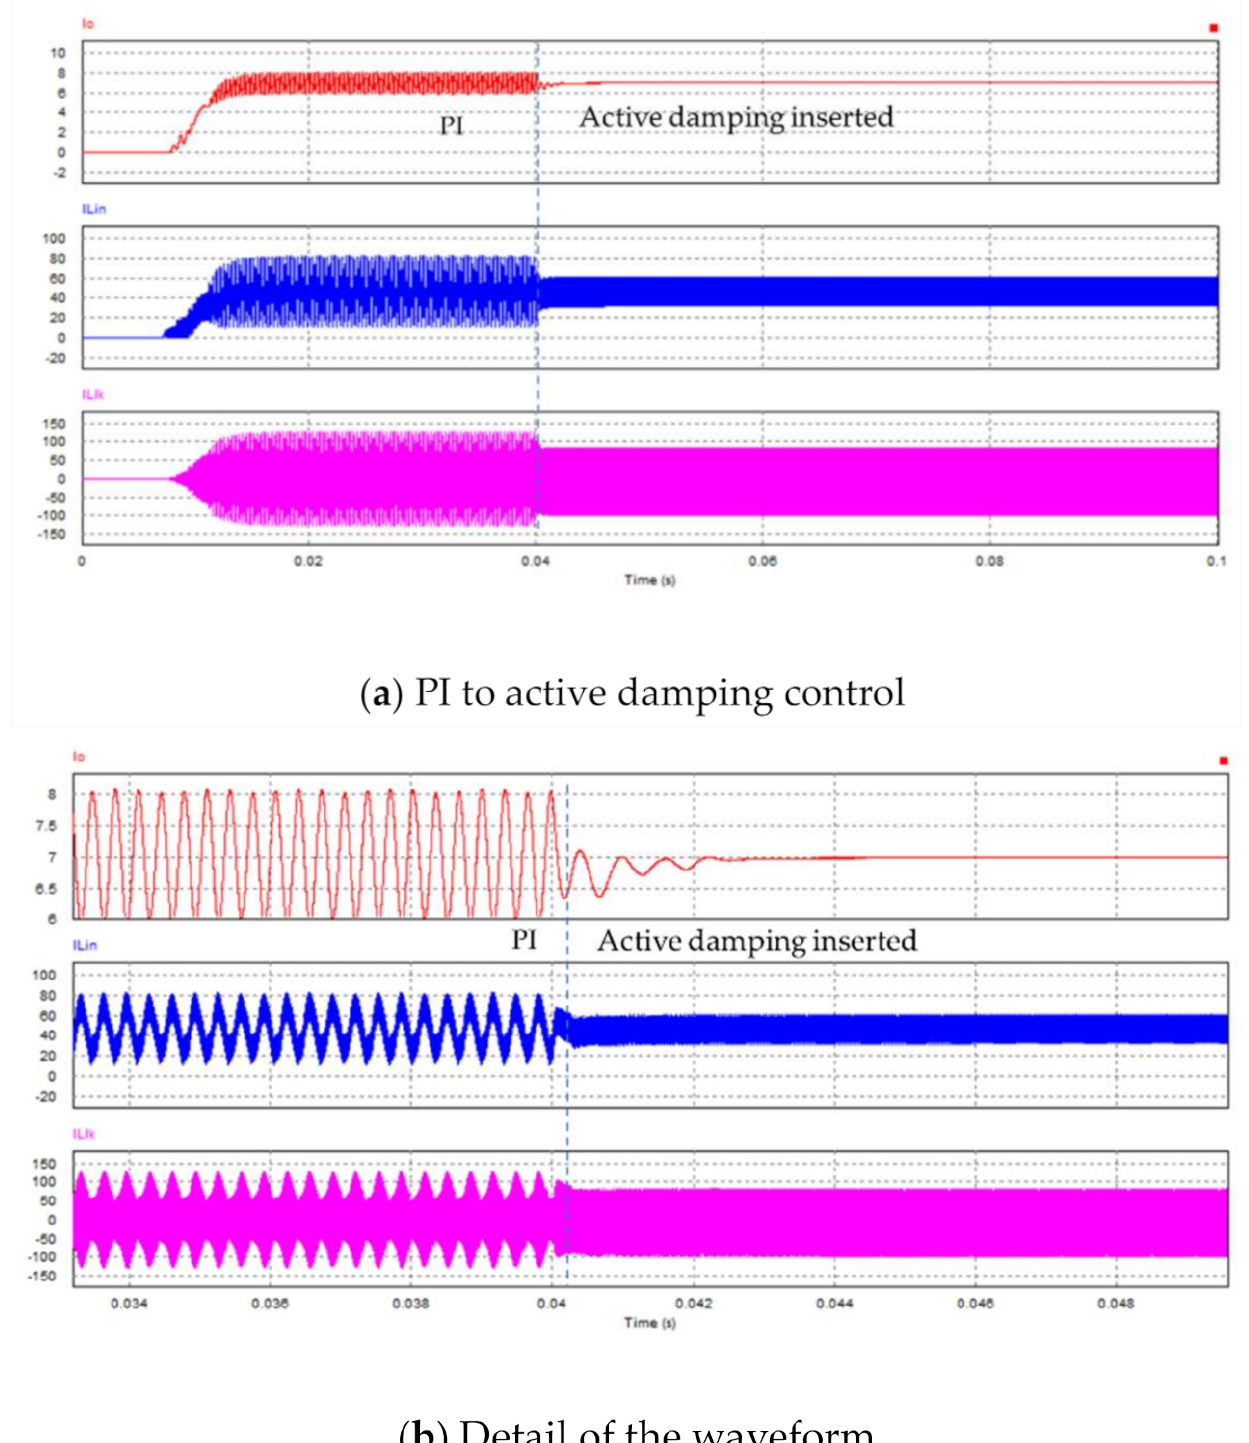
Figure 24. Simulation result of inserting active damping ( I o = 7 A )